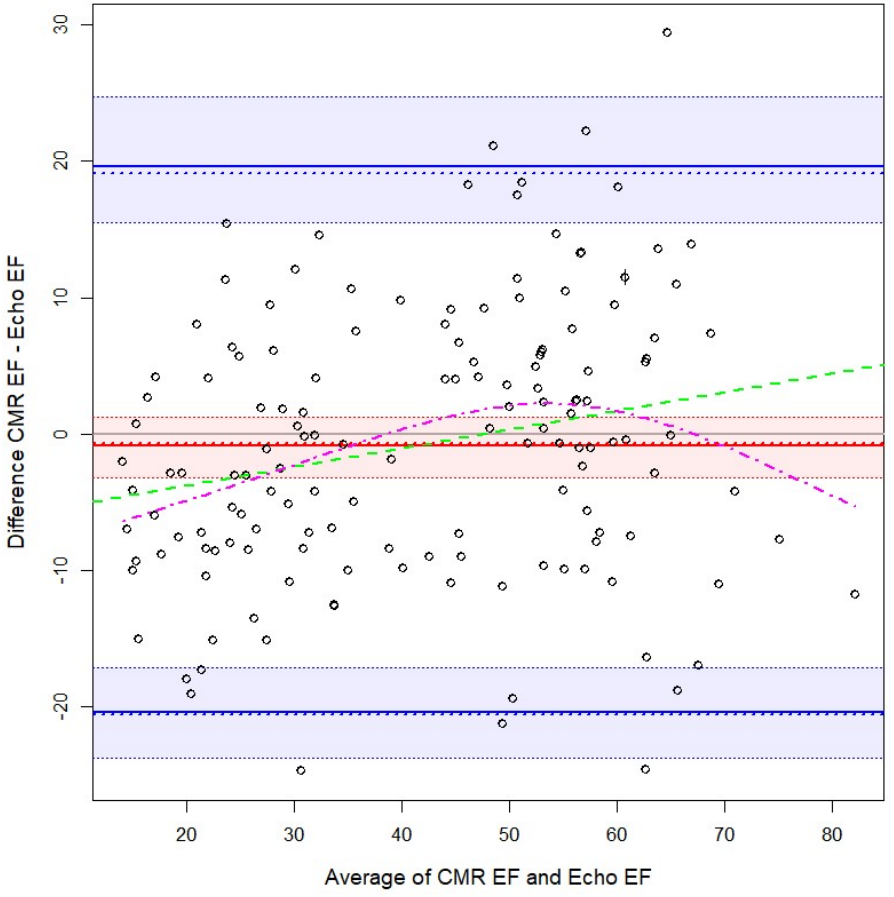
Figure 3. Bland-Altman plot for cardiac magnetic resonance imaging and cardiac echography of ejection fraction. ejection CMR, cardiac magnetic resonance imaging; EF, ejection fraction; LV, left ventricle; continuous red line, bias as 50th quartile; dotted red line, bias as mean; red interval, 95% bootstrapped confidence interval for 50th quartile; straight blue lines, limits of agreement at 2.5th and 97.5th quartiles; blue interval, 95% bootstrapped confidence interval for limits of agreement at 2.5th and 97.5th quartiles; dotted blue lines, limits of agreement at 1.96 standard deviations from the mean; dashed green line, linear regression line; magenta dot-dashed line, general additive model fit with a spline.